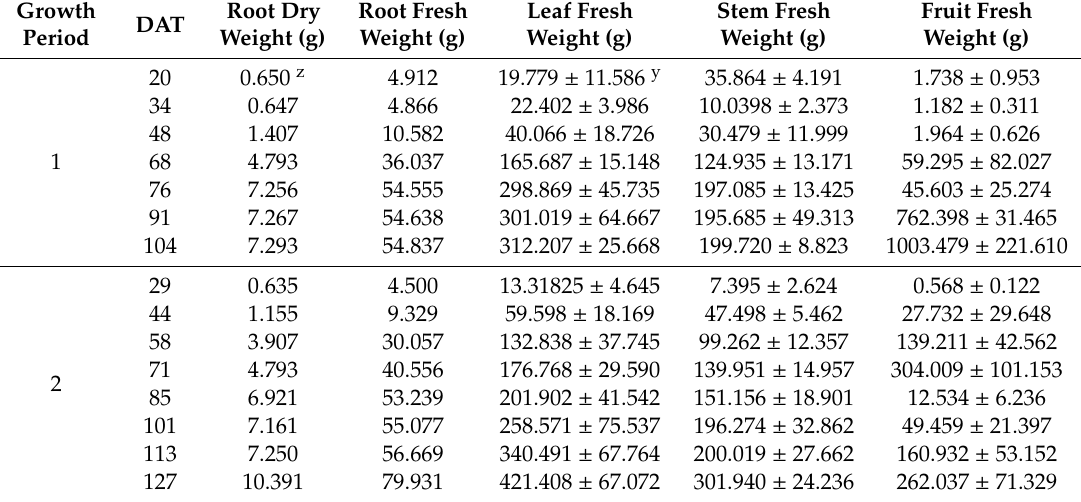
Table 2. Growth survey results of roots, leaves, stems, and fruits per plant according to days after transplanting (DAT) for di ff erent growth periods. Root fresh weight was calculated with root dry weight and A / B ratio in Table 1. Growth periods 1 and 2 were 8 February–28 May 2018 and 30